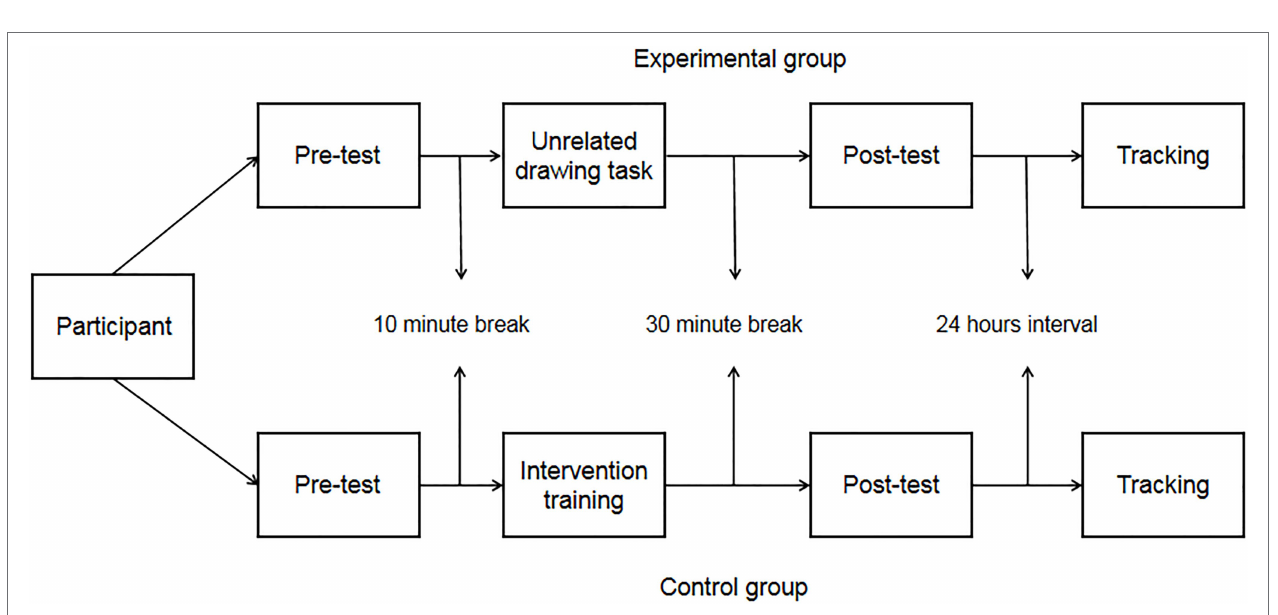
FIGURE 1 | Experimental flow chart of Experiment